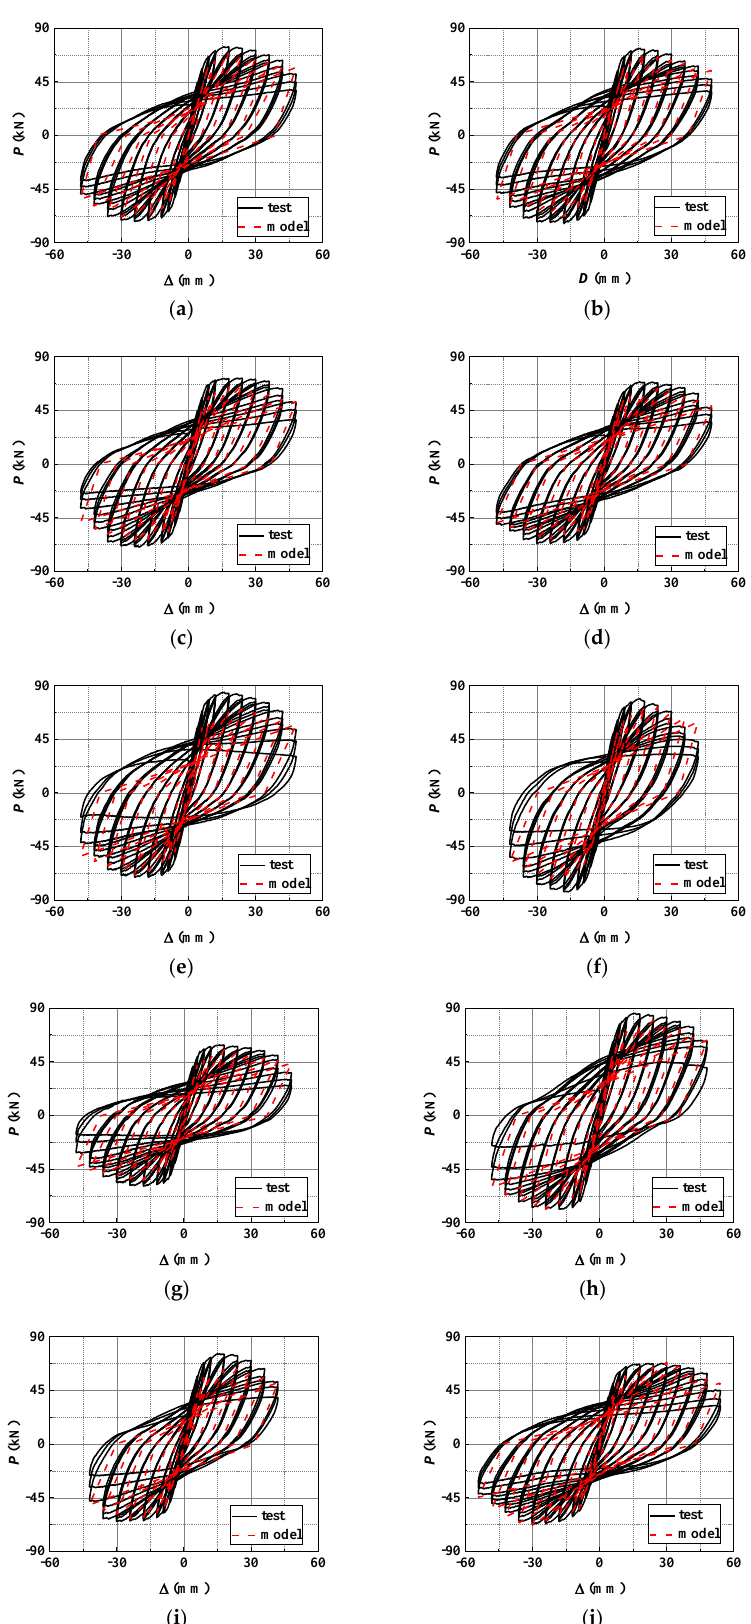
Figure 25. Comparison between the calculated hysteretic curve and test hysteretic curve. ( a ) JP-F0. ( b ) JP-F1. ( c ) JP-F3. ( d ) JP-F5. ( e ) JP-A0.225. ( f ) JP-A0.3. ( g ) JP-L12. ( h ) JP-L16. ( i ) JP-J100. ( j ) JP-J50. Table 7. Comparison of load test value and calculation value.